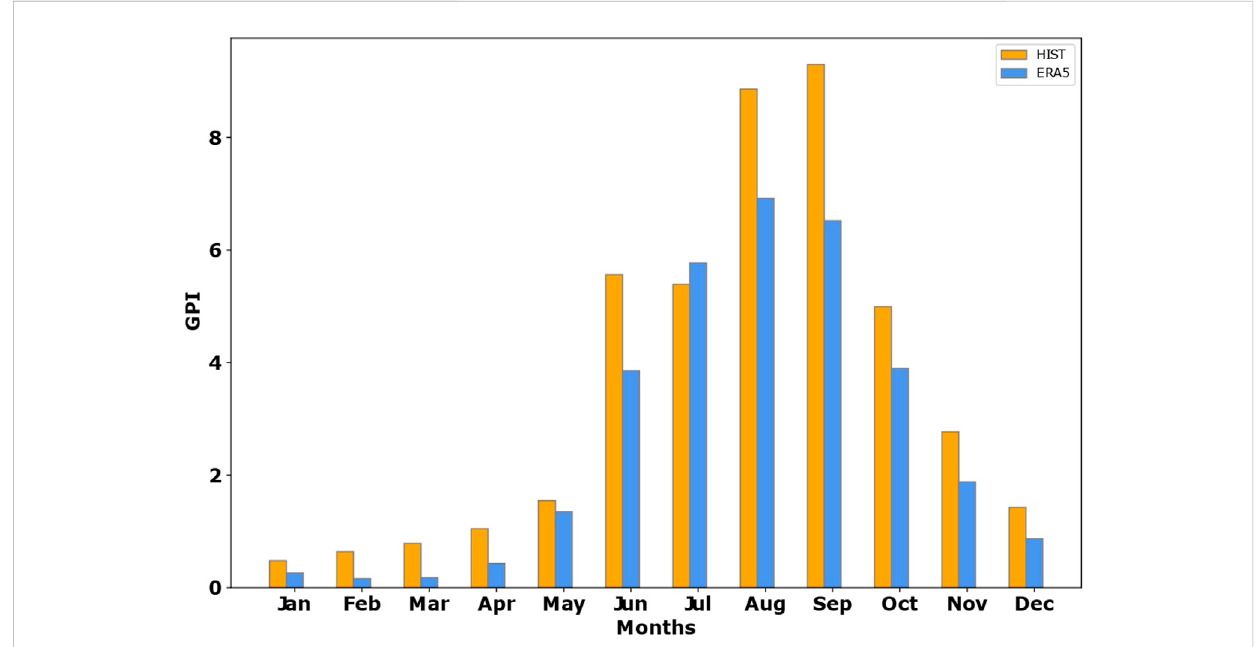
FIGURE 7 Time-mean (1979 – 2005) annual cycle of GPI over WNP (120 o E-180 o E, 5 o N-30 o N) from HIST (orange bars) and ERA5 reanalysis (blue bars).